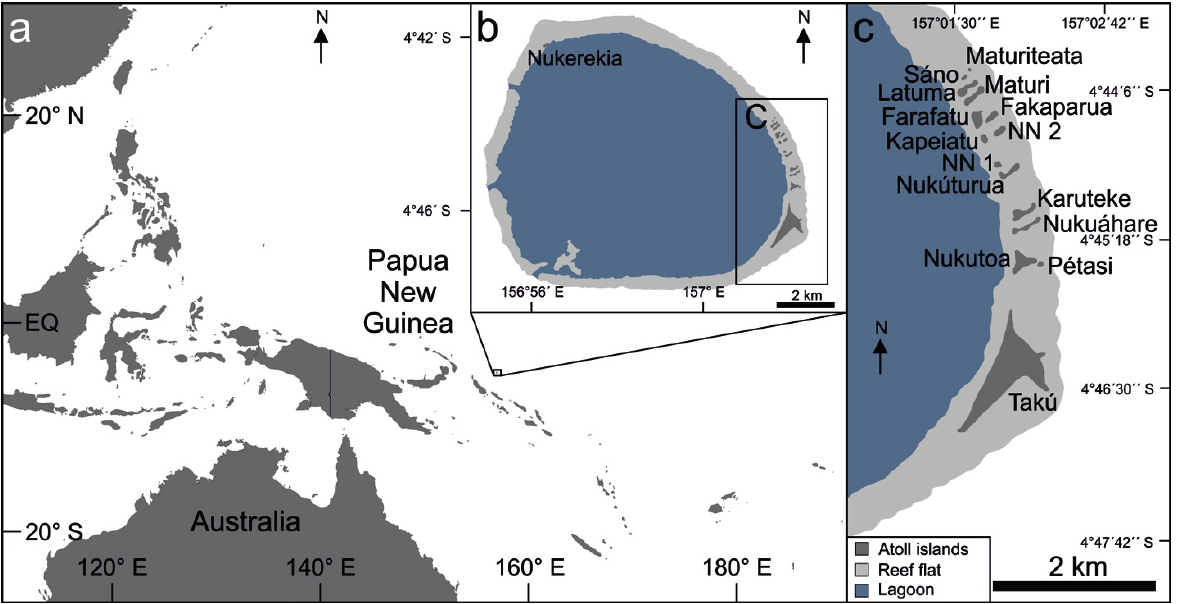
Figure 1. ( a ) Location of Takú Atoll in the tropical Western Pacific; ( b ) General map of the entire atoll; ( c ) Close-up of the eastern rim of the